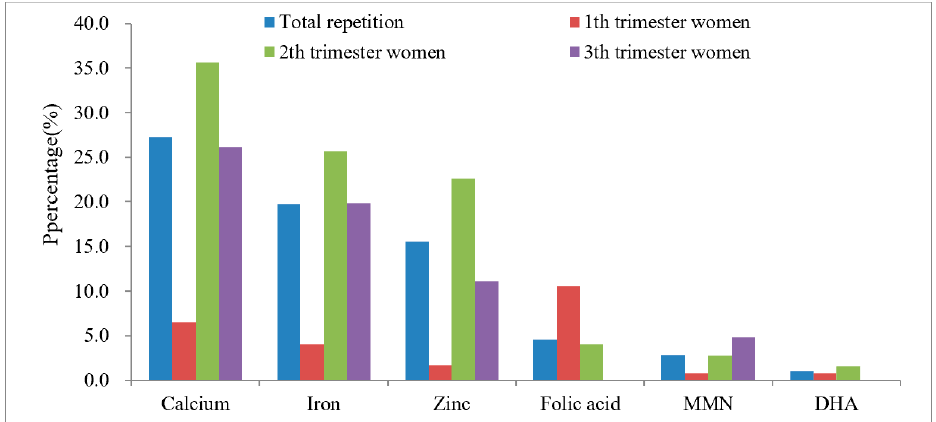
Figure 2. Repeated supplement rate of several common nutrients among pregnant women ( n = Figure 1. Usage rate of several common dietary supplements in different stages of pregnancy 572). ( n = 572).